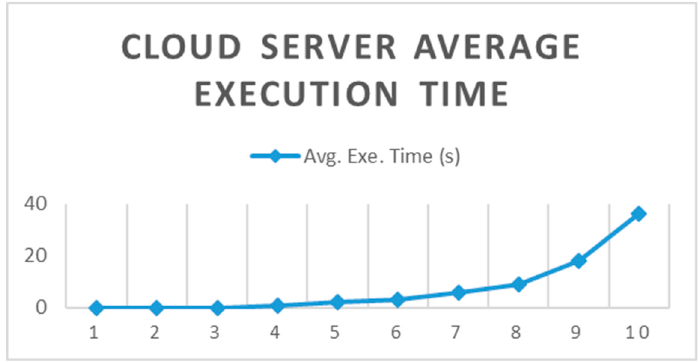
Figure 10. Cloud server average execution time.